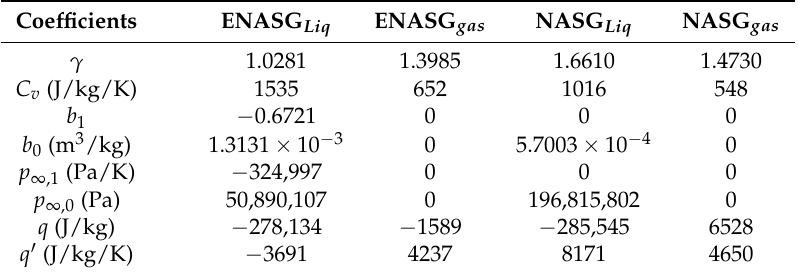
Table 2. Extended NASG (ENASG) coefficients for oxygen. The NASG parameters are also given and determined with the method given in Le Métayer and Saurel [14] except for the liquid reference entropy q (cid:48) that is computed with the NASG reduction of Equation (A31) (see Appendix C). The NASG oxygen parameters are determined with n = 41 experimental saturation points in the temperature range T exp [60 K–100 ∈